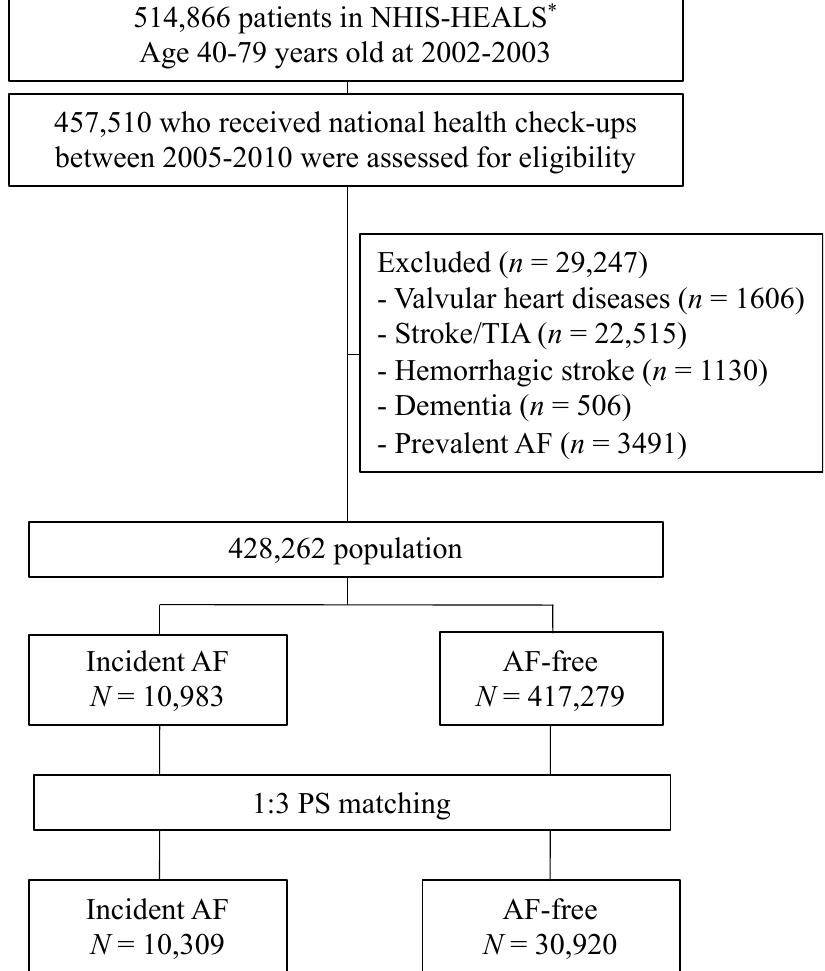
Figure 1. Flowchart of the enrollment procedure of the study population and analyses. TIA, transient ischemic attack; AF, atrial fibrillation. * The National Health Insurance Service-Health Screening Cohort (NHIS-HEALS) in Korea.